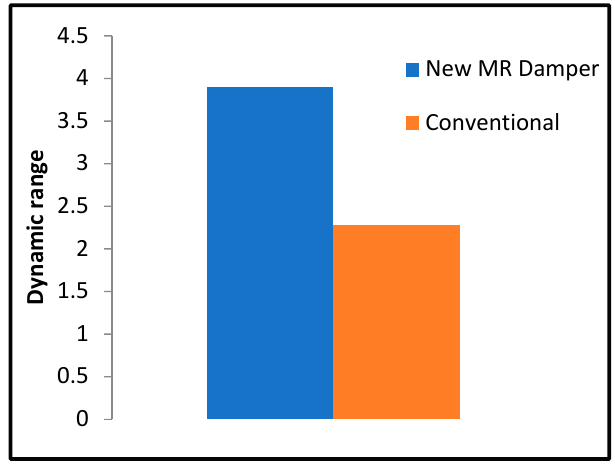
Figure 17. Dynamic range of new MR damper at 0.5 A.